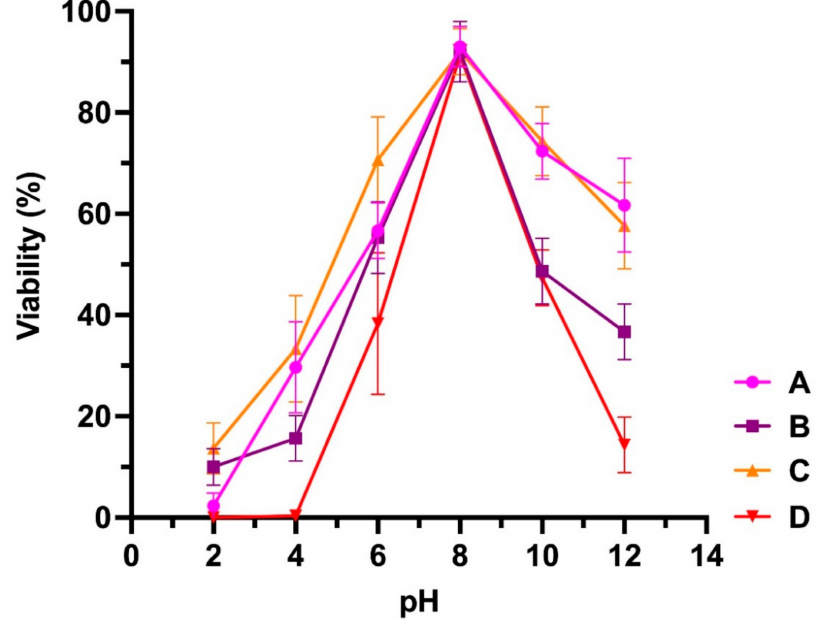
Figure 3. Sensitivity of bacteriophages to pH. (A) Pseudomonas Phage_AUS034, (B) Pseudomonas Phage_AUS301, (C) Pseudomonas Phage_AUS260 and (D) Pseudomonas